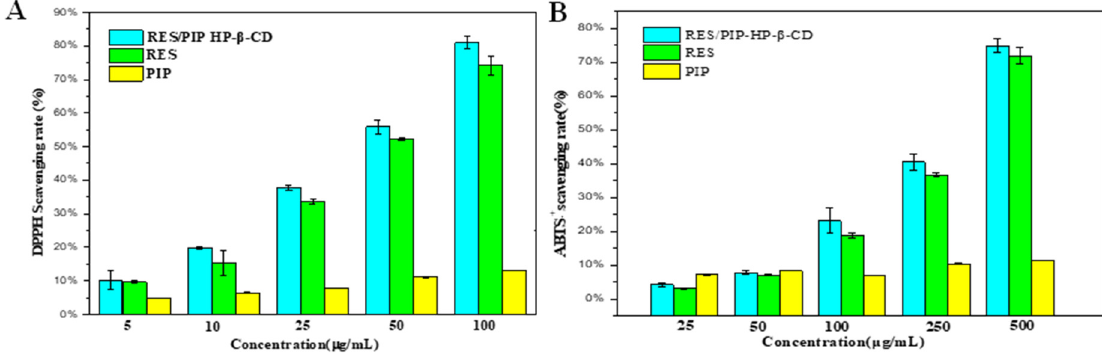
Figure 8. ( A ) DPPH scavenging rate of raw RES, raw PIP, and RES/PIP-HP- β -CD. ( B ) ABTS + radical scavenging rate of raw RES, raw PIP, and RES/PIP-HP- β -CD.